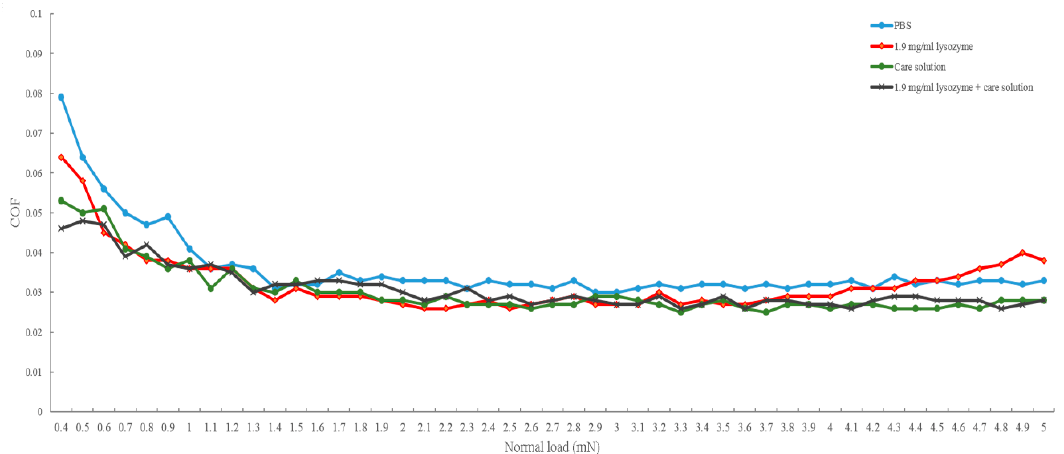
Figure 2. The comparison of the friction coefficient of different solutions for load variations. The friction coefficient of PBS (blue line), 1.9 mg/mL lysozyme solution (red line), γ -PGA-containing care solution (green line), and 1.9 mg/mL lysozyme and γ -PGA-containing care solution (black line) when normal load varies from 0.4 mN to 5 mN at velocity of 0.2 cm/s.